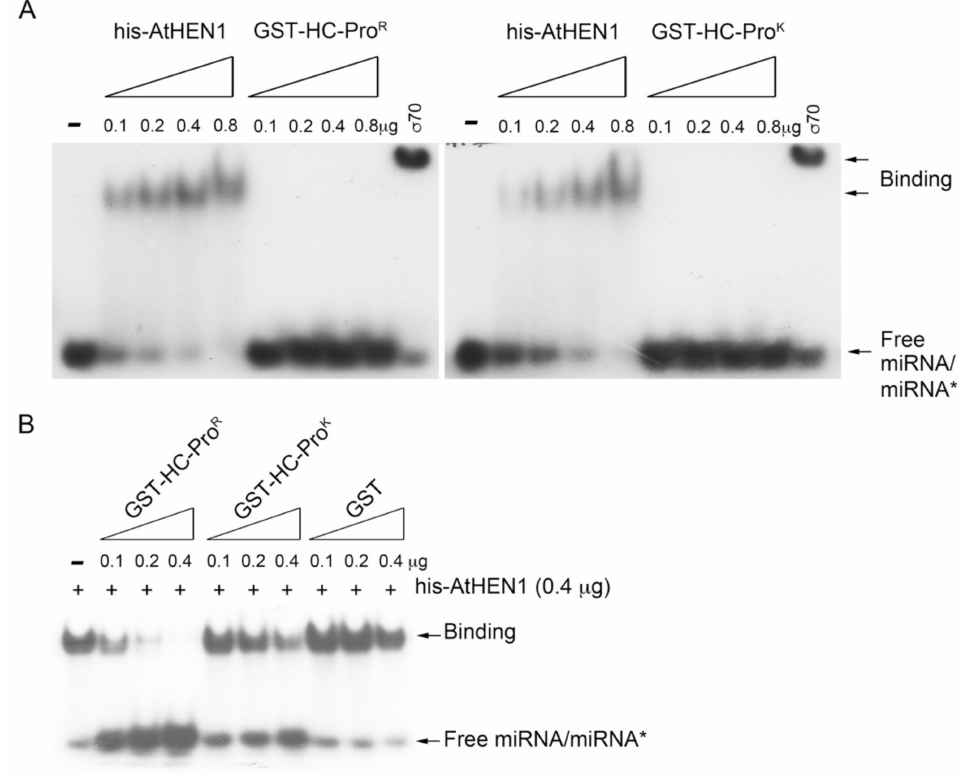
Figure 5. The miRNA/miRNA* and HC-Pro R/K -binding assay. ( A ) EMSA to examine the miRNA/miRNA*-binding ability of his-AtHEN1 and GST-HC-Pro R or GST-HC-Pro K . ( B ) In vitro competition